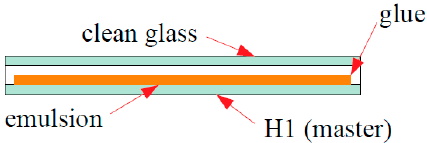
Figure 2. Hologram H1 is sealed with UV glue.